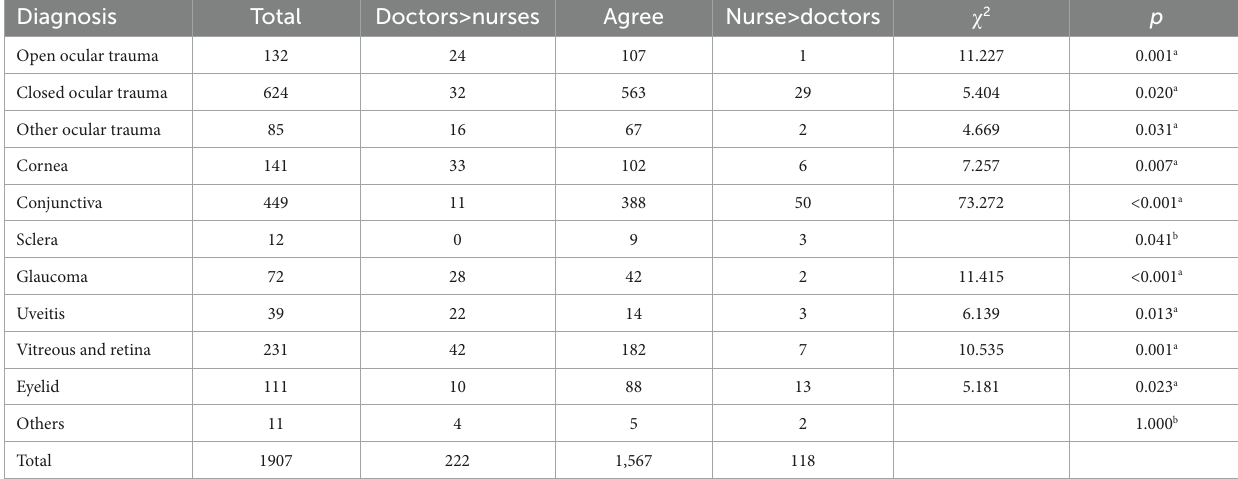
TABLE 4 Comparison of the tendency to up- or down-triage based on